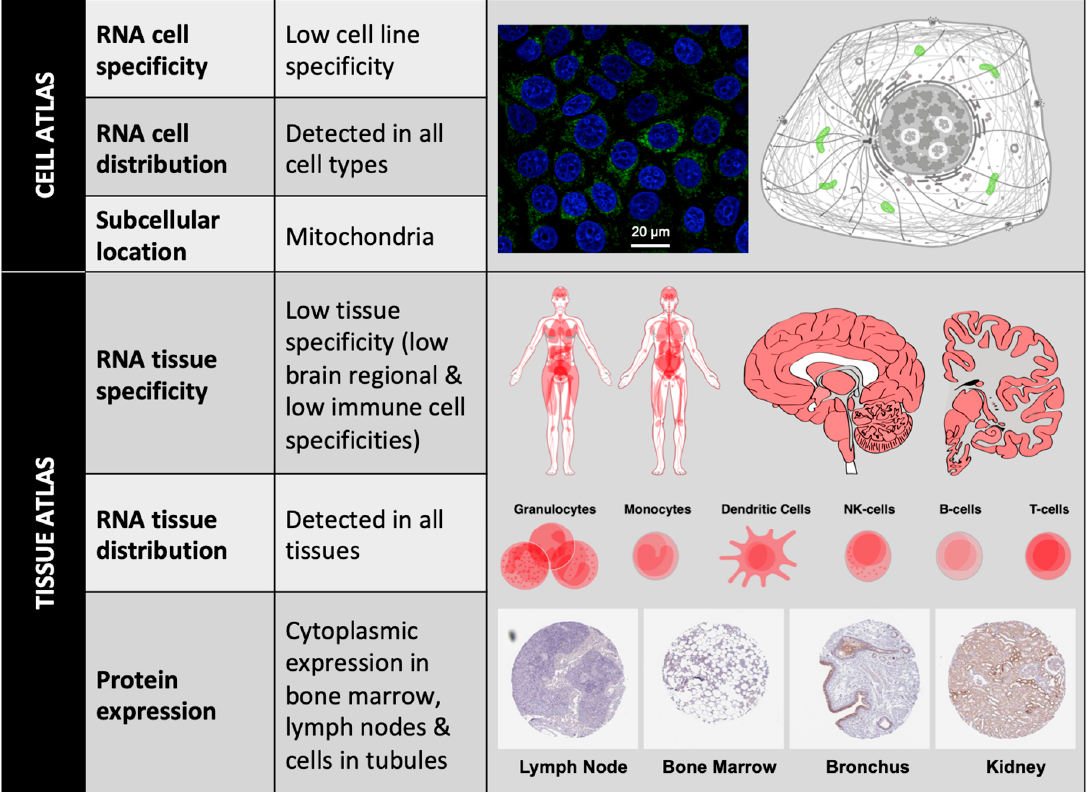
Figure 2. BCL-xL localization. BCL-xL mRNA expression levels can be detected in different cell lines and cell types; BCL-xL protein subcellular location is mainly restricted to mitochondria (Image: MCF7 cells stained with CPTP-BCL2L1-2 antibody obtained from NCI-CPTAC). Consensus data for BCL-xL RNA expression in 55 human tissue types and six blood cell types reveals low tissue specificity. BCL-xL immunohistochemistry in four different tissues stained with HPA035734 antibody (obtained from Atlas Antibodies Sigma-Aldrich). All figures have been obtained from The Human Protein Atlas.